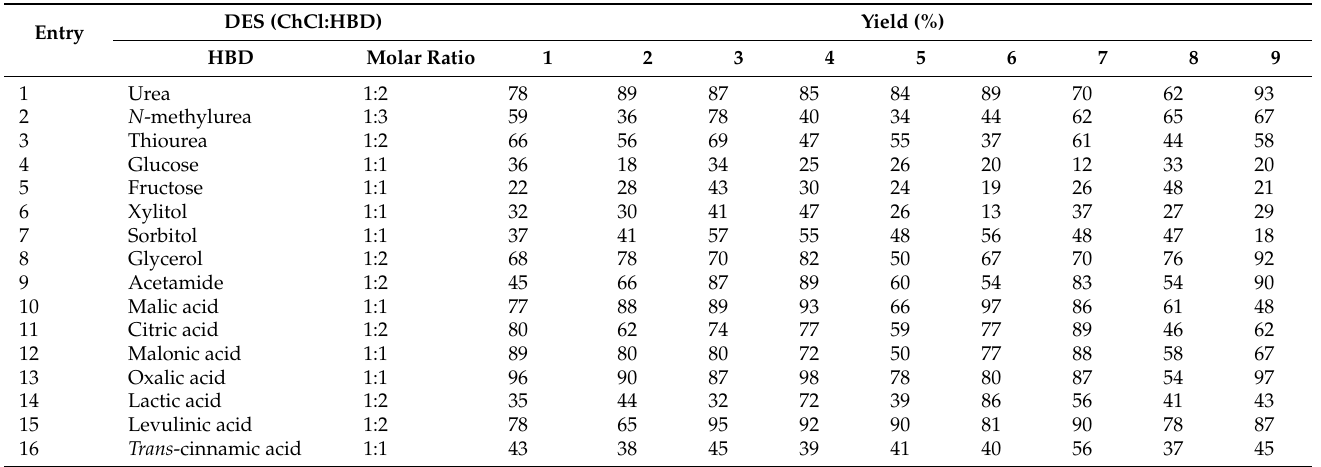
Table 4. Yields ( % ) of the microwave method for the synthesis of isonicotinamide quaternary salts ( 1 – 9 ) over 20 min at a temperature of 80 ◦